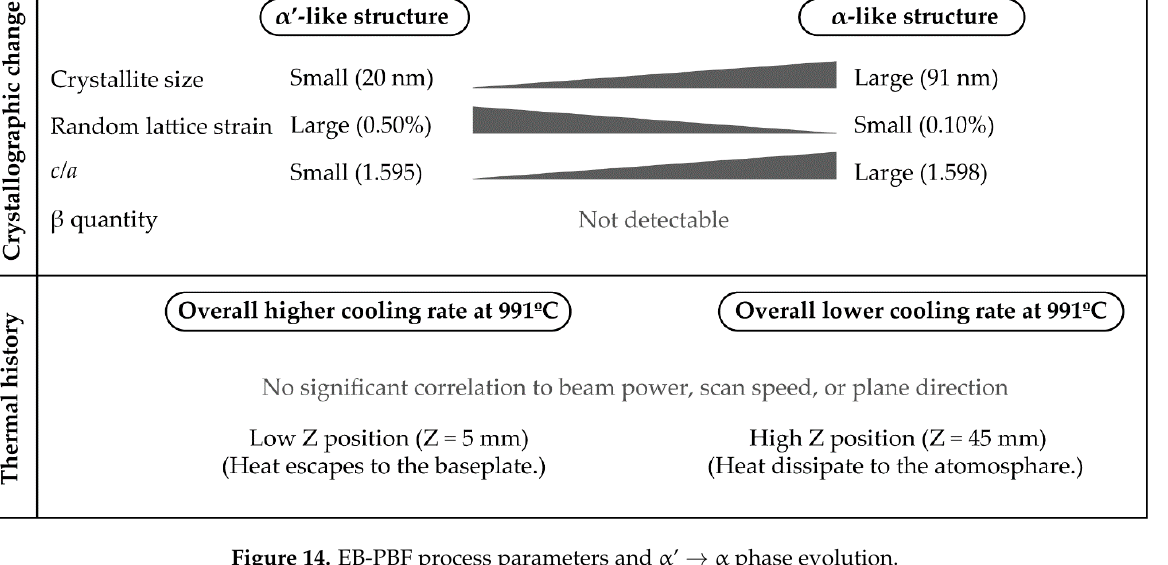
Figure 14. EB-PBF process parameters and α ’ → α phase evolution